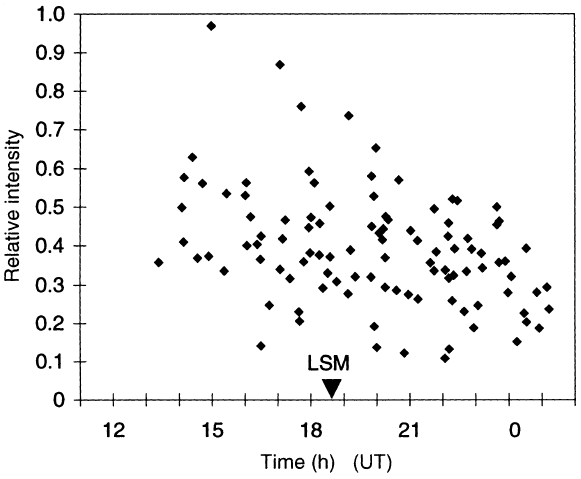
Fig. 6. OH(6–2) emission intensity variation for the principal data set (solar altitude < (cid:255) 18 (cid:14) , lunar altitude < 0 (cid:14) , no cloud, OI < P 1 (cid:133) 3 (cid:134) , 104 spectra) plotted as a function of time. The solid arrow indicates local